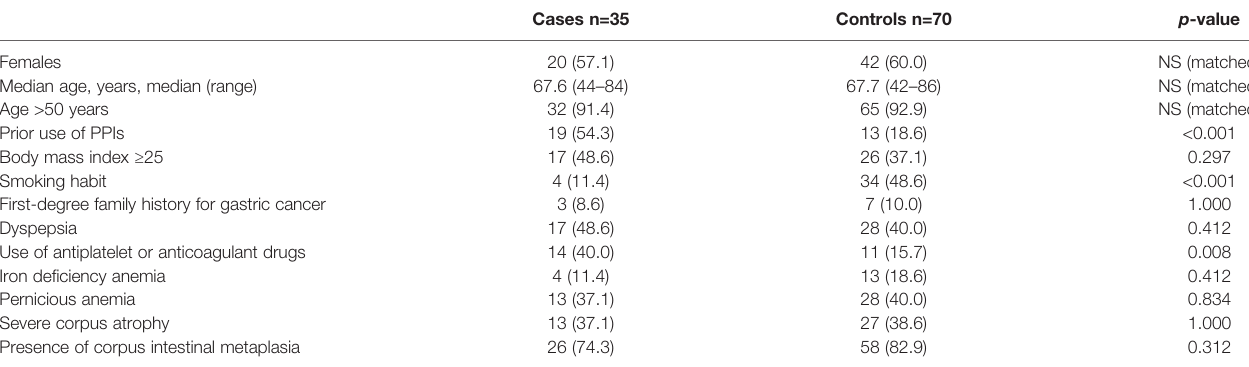
TABLE 2 | Comparison of main characteristics between patients with autoimmune atrophic gastritis with gastric neoplastic lesions (cases) and patients with autoimmune atrophic gastritis without gastric neoplastic lesions (controls).